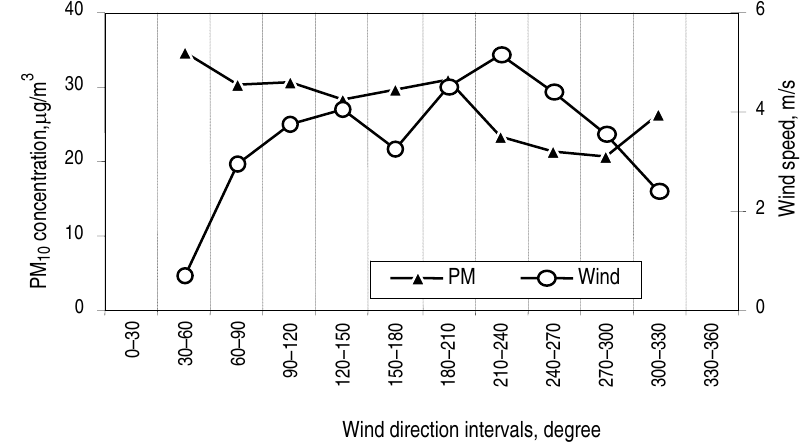
Fig 4 . Relationship between PM 10 concentration and wind speed at different wind direction intervals